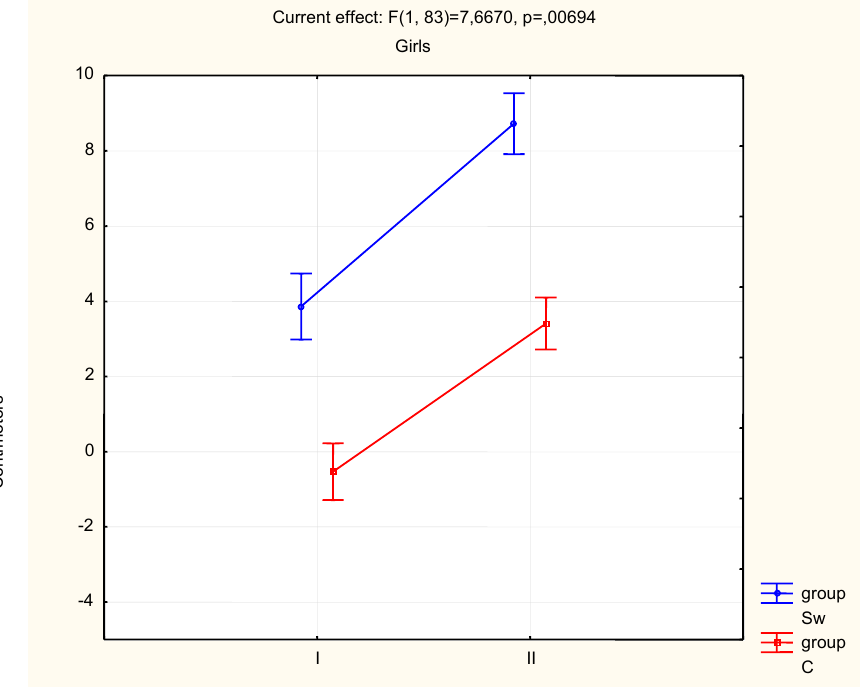
Fig 3. Changes of the Sit-and-Reach Test (flexibility) results in Swimmers (Sw) group and Control (C)